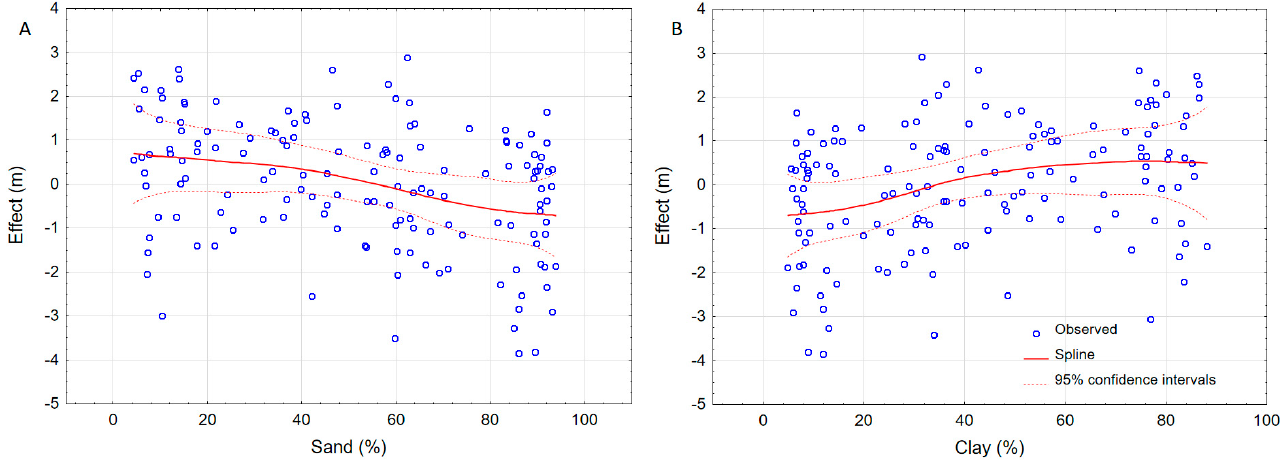
Figure 3. Partial effects of sand content ( A ) and clay content ( B ) in soil on the site index for oak. The effect of sand content and clay content change is displayed with all other factors held constant.